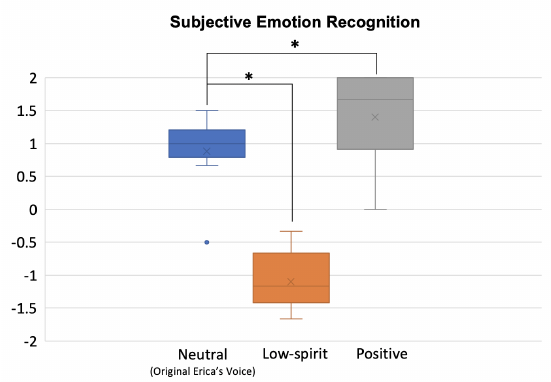
Figure 3. Emotion evaluation of the original and converted emotion. * indicates the found significant